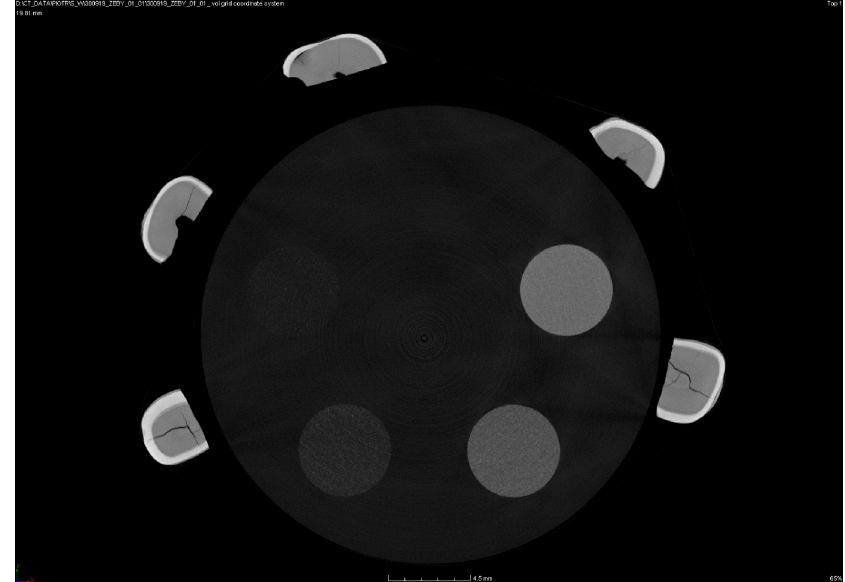
Figure 3. An example of a microtomographic scan containing five premolars with a density template.